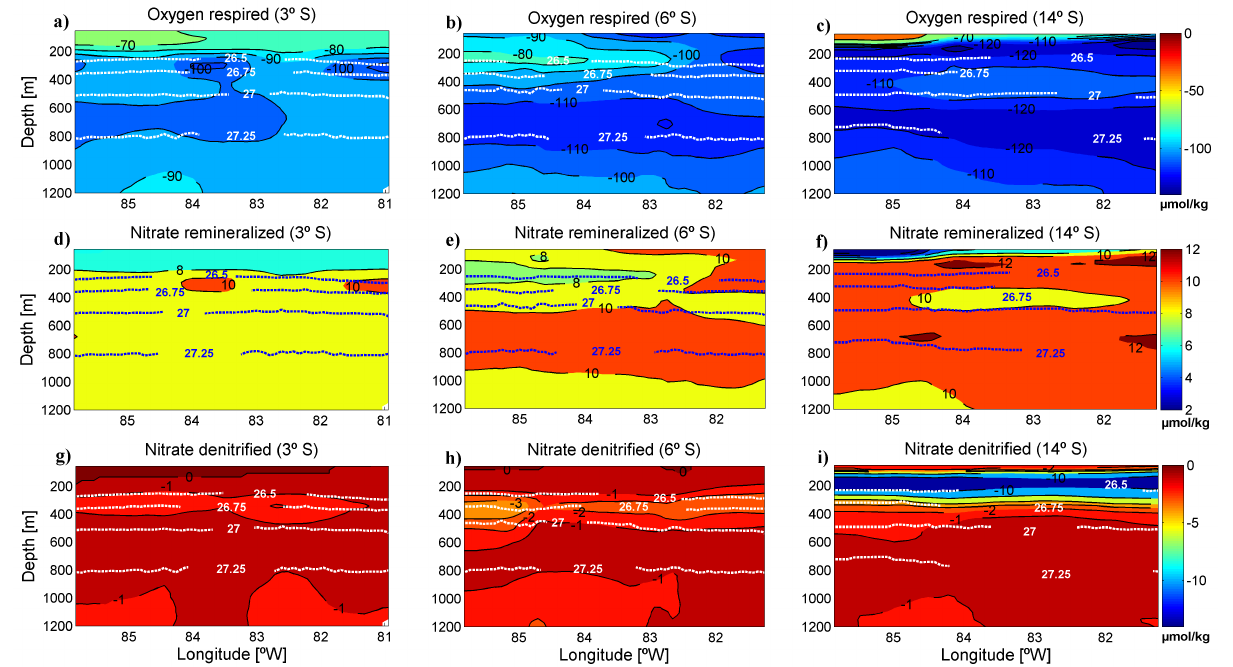
Fig. 6b. OMP-derived biogeochemical activity within the water column for the three zonal sections (3 ◦ , 6 ◦ and 14 ◦ S) completed during the M77 cruise (February 2009): (a) oxygen respired (µmolkg − 1 ) at 3 ◦ S, (b) oxygen respired (µmolkg − 1 ) at 6 ◦ S, (c) oxygen respired (µmolkg − 1 ) at 14 ◦ S, (d) nitrate remineralized (µmolkg − 1 ) at 3 ◦ S, (e) nitrate remineralized (µmolkg − 1 ) at 6 ◦ S, (f) nitrate remineralized (µmolkg − 1 ) at 14 ◦ S, (g) nitrate denitrified (µmolkg − 1 ) at 3 ◦ S, (h) nitrate denitrified (µmolkg − 1 ) at 6 ◦ S, (i) nitrate denitrified (µmolkg − 1 ) at 14 ◦ S. Selected isopycnals are shown as dotted white/blue